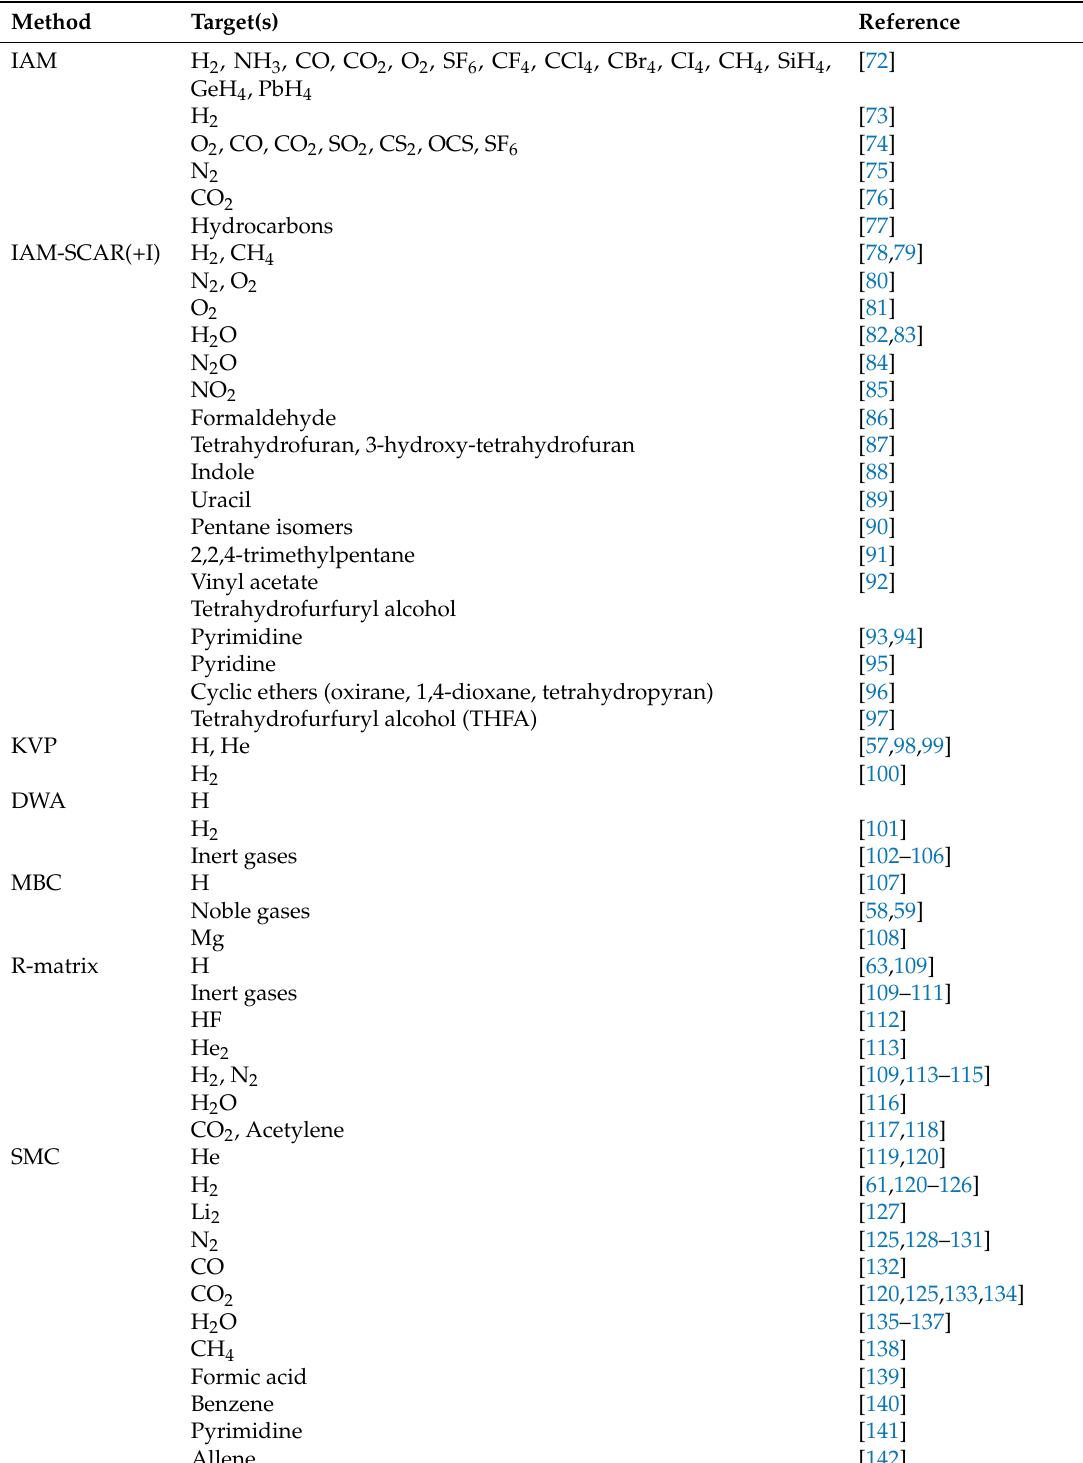
Table 1. References for positron scattering from various target molecules using various methods: independent atom model (IAM), IAM with screening correction (IAM-SCAR) with interference (IAM-SCAR+I), Kohn variational principle (KVP), distorted wave approximation (DWA), many-body-calculation (MBC), R-matrix, Schwinger multichannel calculations (SMC), close-coupling (CC)